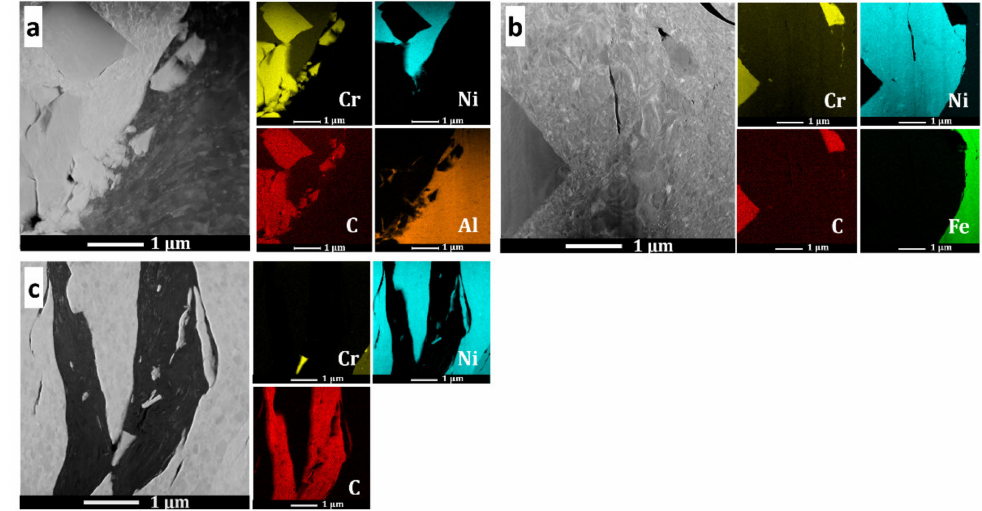
Figure 9. STEM microstructures and chemical element distribution maps in the coatings in the area near the Al alloy substrate ( a ), steel substrate ( b ), and graphite ( c